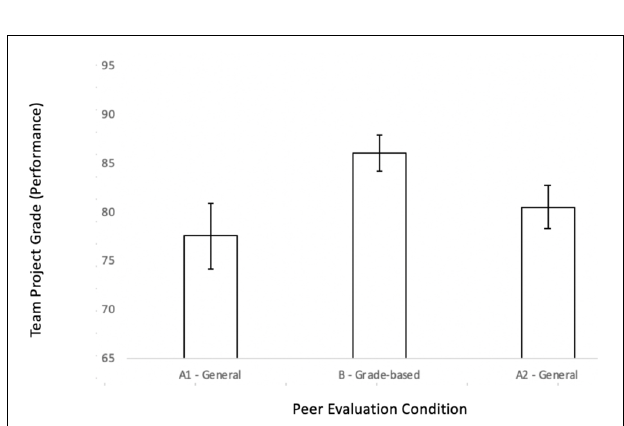
FIGURE 2 | Team health scores across conditions. Error bars represent 95% confidence intervals.